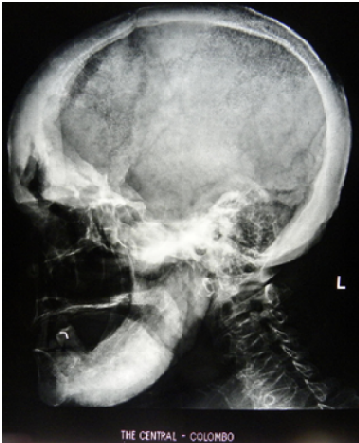
Figure 1. Xray skull – lateral.